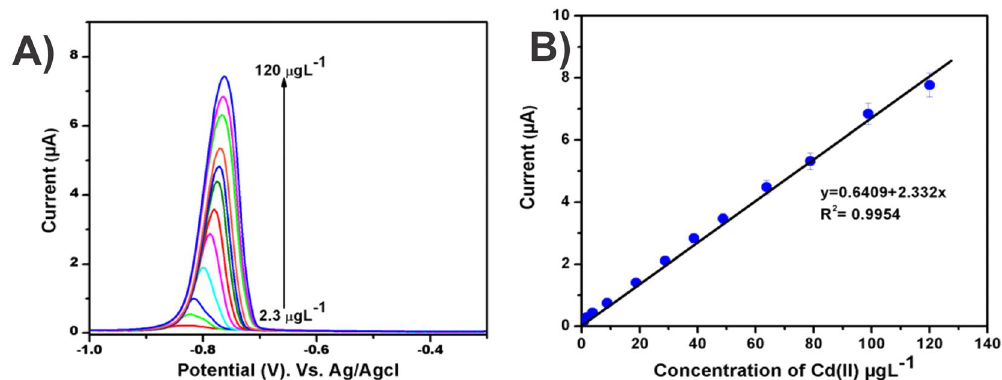
Figure 8. ( A ) Responses of MnCo 2 O 4 modified GCE for the addition of different concentrations of Cd (II) from 2.3 to 120 µ g L − 1 . ( B ) The corresponding linear plot for I pa vs. concentration of Cd (II).